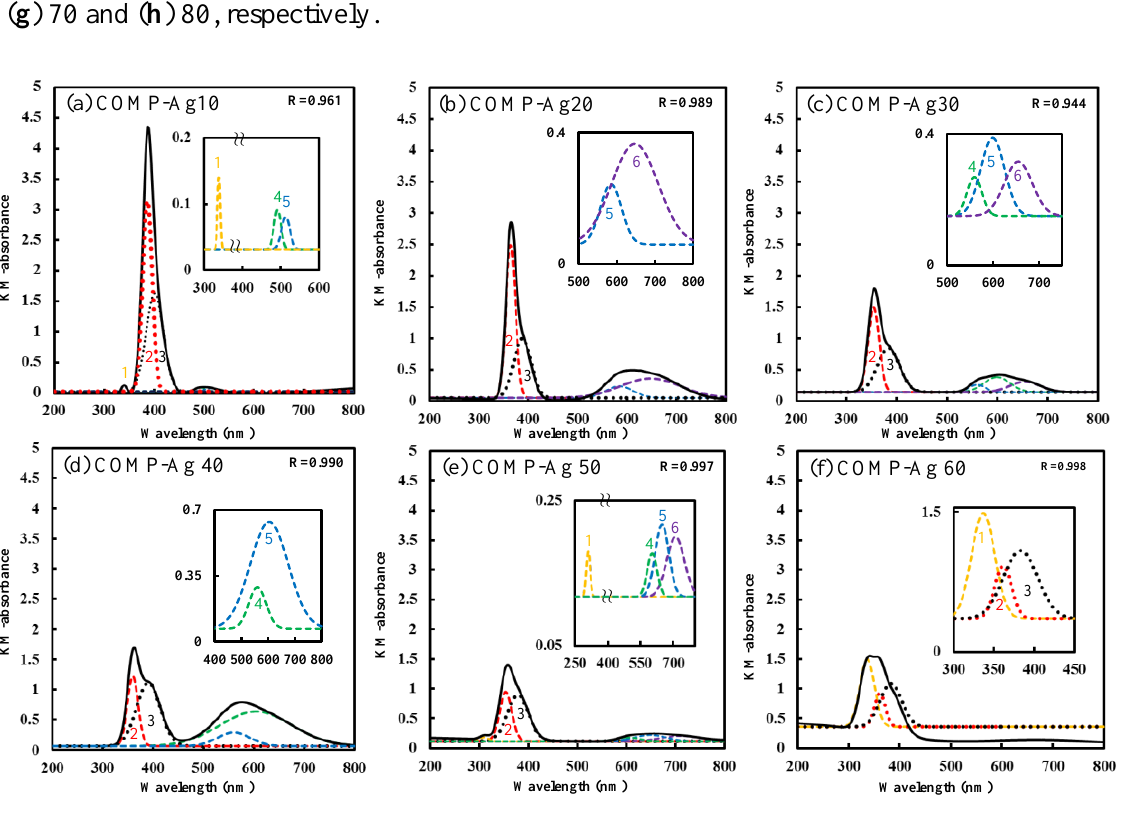
Figure 6. UV–Vis diffuse reflectance spectra (DRS) of Ag- NP/TiO composite thin films at 2 various amounts of Ag